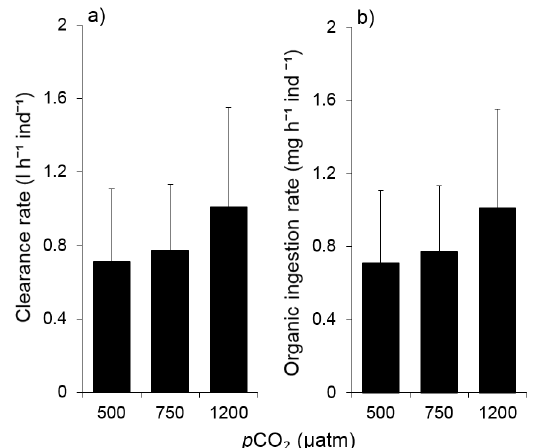
Fig. 1. (a) Clearance rates and (b) organic ingestion rates of the mussel Choromytilus chorus exposed to contrasting p CO 2 levels. Bars correspond to means ±1 SE